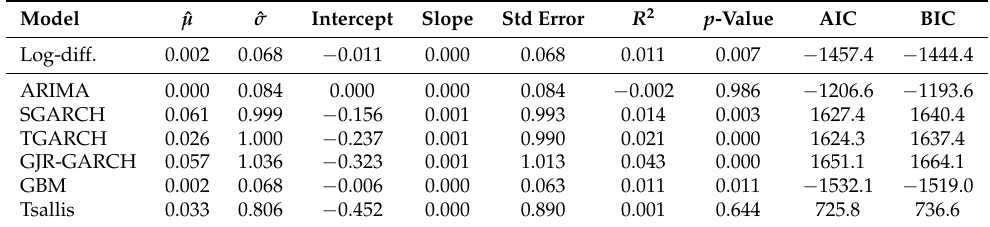
Figure 9. Log − Differenced Residual Q-Q Plot. Table 1. Modelling